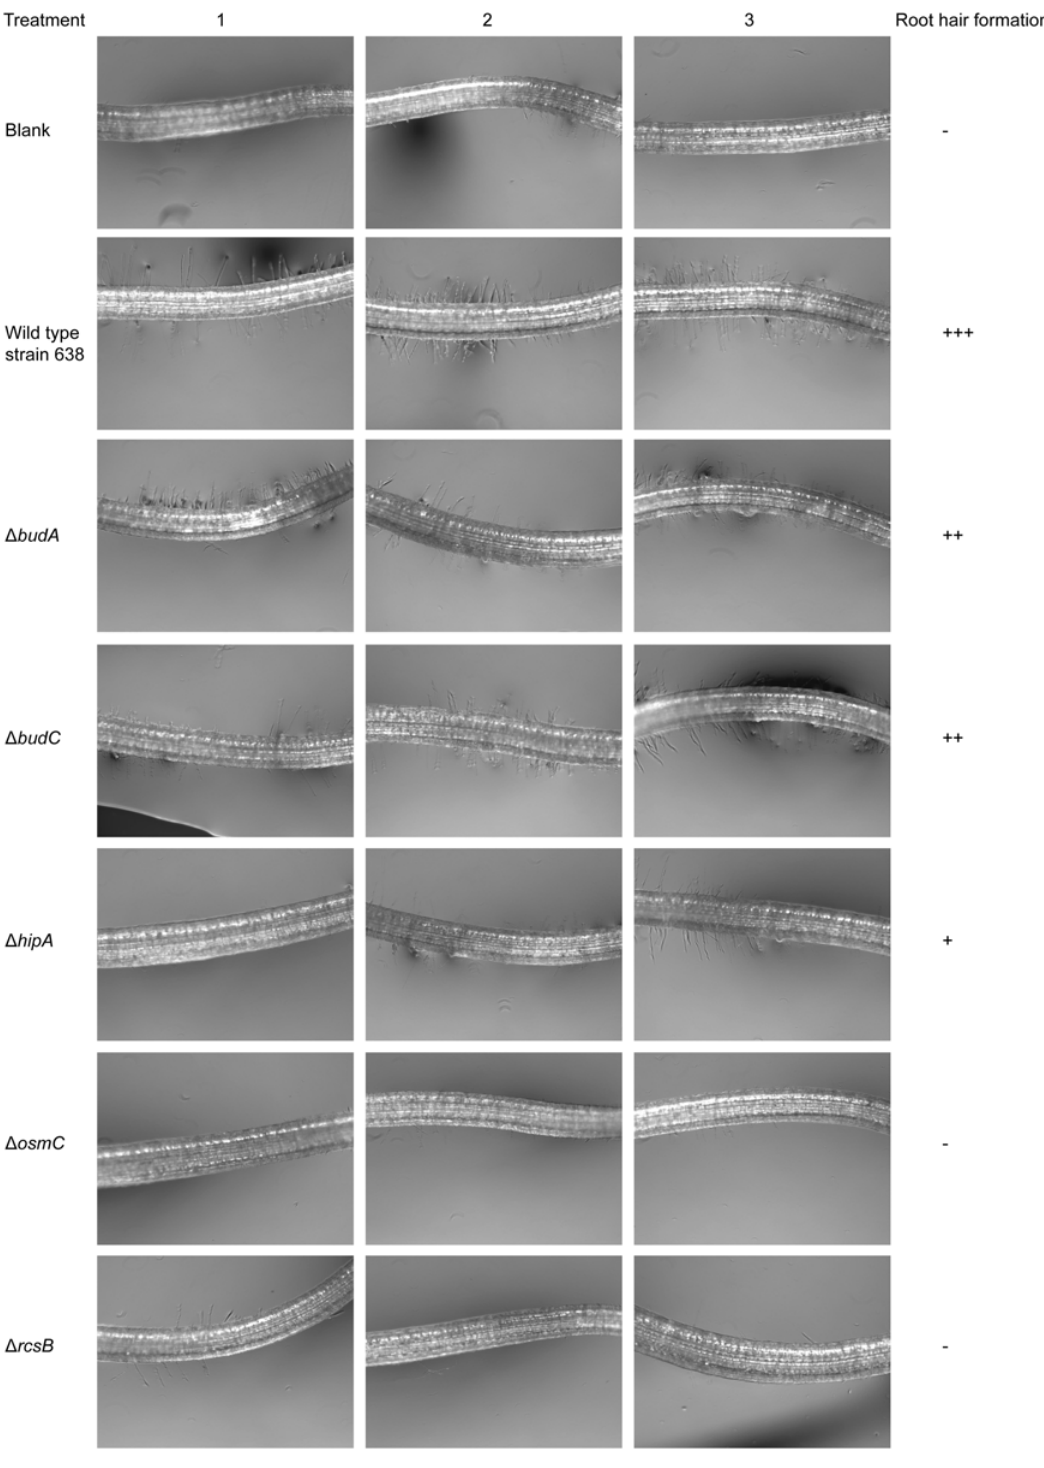
Figure 6. The effects of various mutations on the early development of root hairs by tomato plants after inoculation with wild-type strain Enterobacter sp. 638 and its derivatives. The section of the root, 2 – 3 mm from the root tip, was visualized using light microscopy 48 hours after inoculation. Root hair formation was determined by the average number of root hairs as counted in triplicate within the visual field image of the microscope:-, 0~5 root hairs; +, 6~20 root hairs; ++, 21~40 root hairs; +++, 41~60 root hairs.